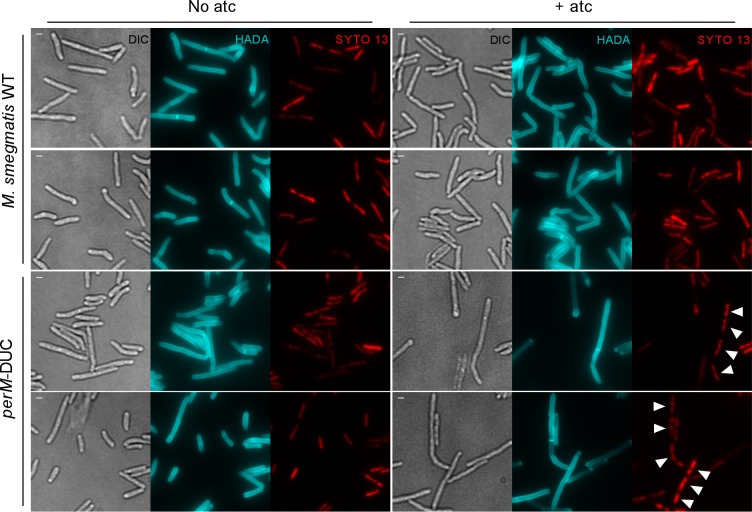
Nucleoid morphology of WT M. smegmatis and perM-DUC in the absence and presence of atc.Representative microscopy images of WT and perM-DUC incubated in 7H9 medium containing 1 mM HADA and in the absence or presence of 200 ng/ml atc for 9 hr. Cells were stained with 5 µM SYTO 13 to label the DNA. Arrowheads point to multiple stained nucleoids (visualized as distinct globular structures) within the perM-DUC mutant incubated in the presence of atc. Scale bar, 1 µm.